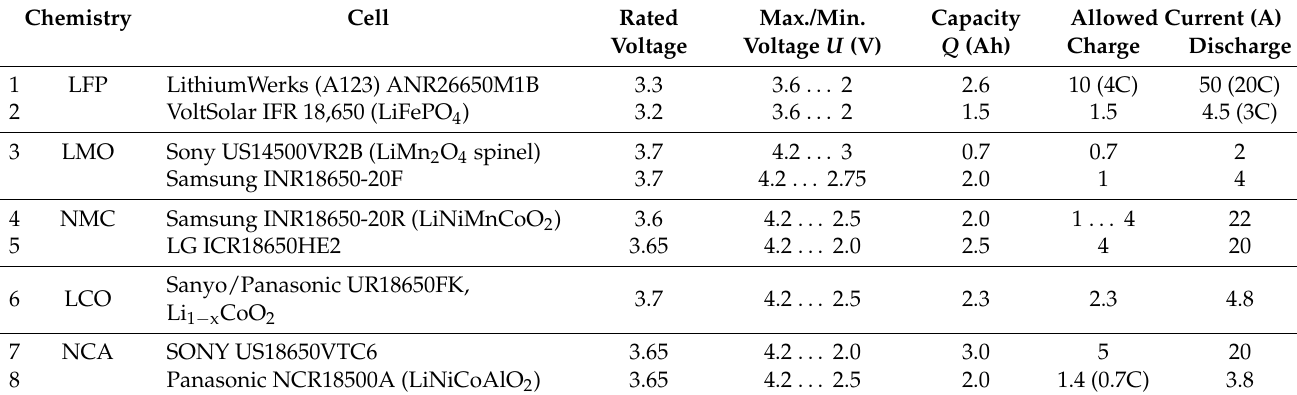
Table 1. Lithium-ion batteries in this study according to manufacturers’ data